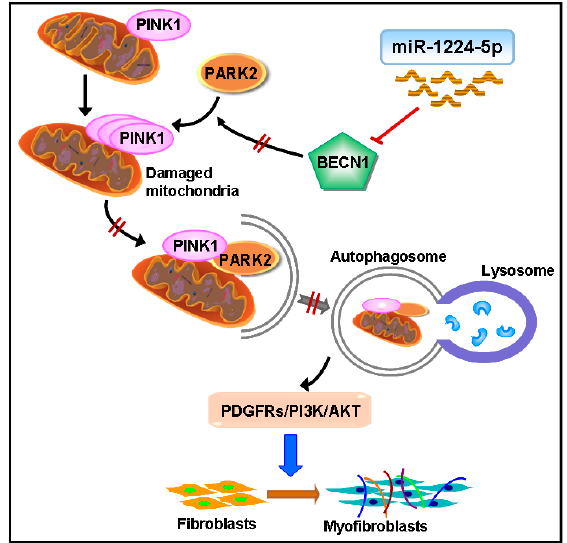
Figure 8. Schematic diagram showing the mechanisms by which miR-1224-5p